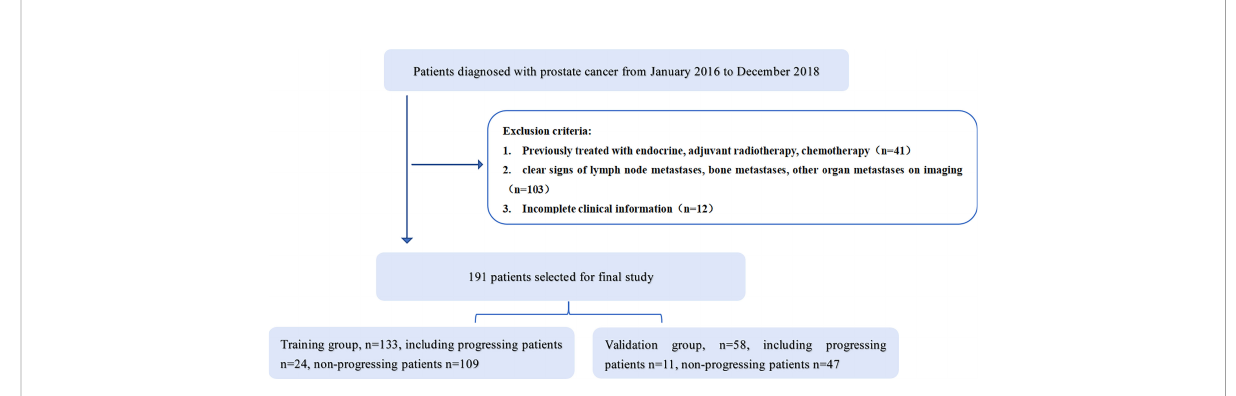
FIGURE 1 Patient selection fl ow chart. Includes exclusion criteria and